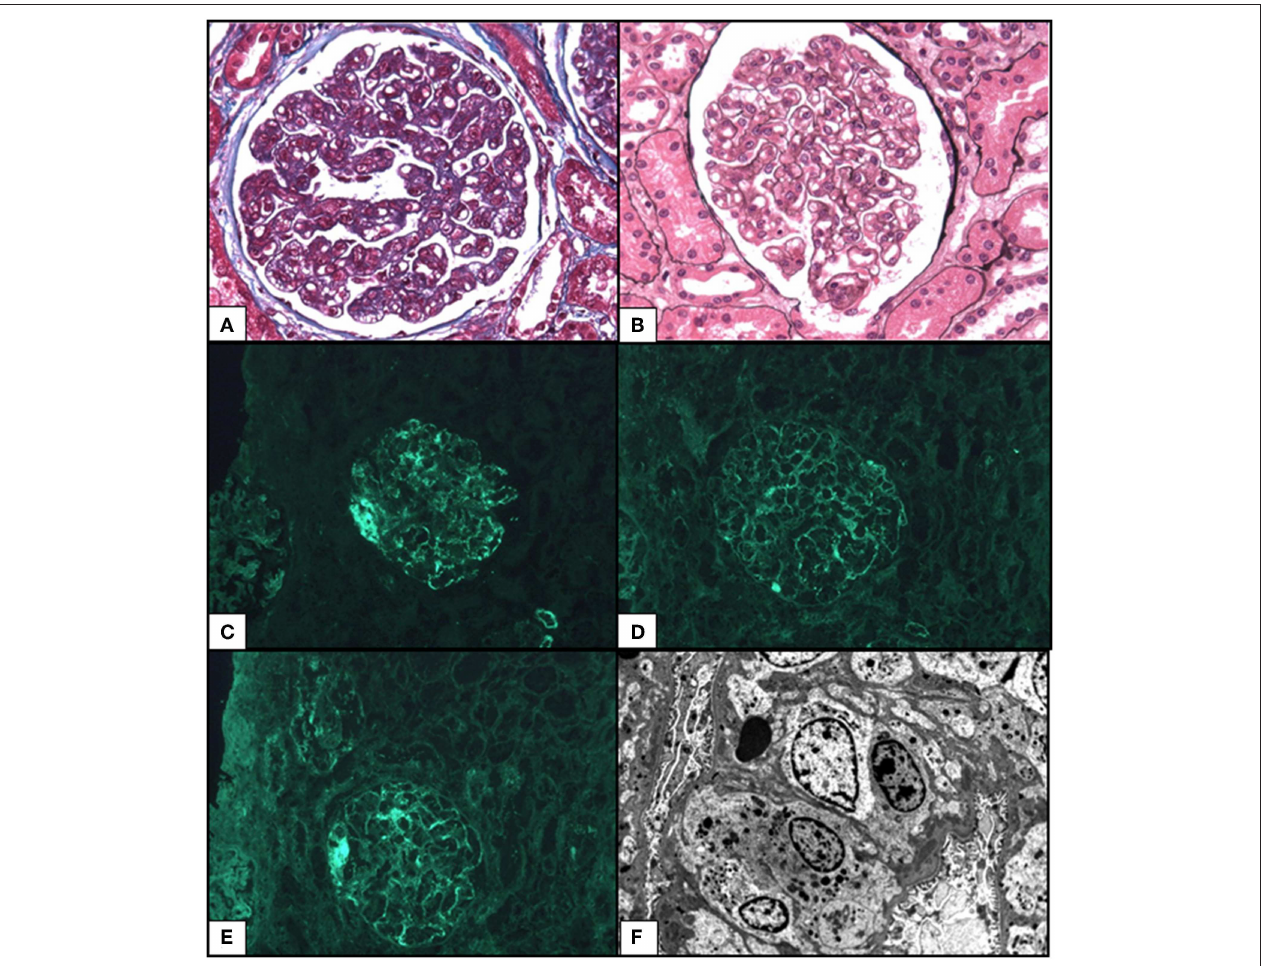
FIGURE 2 | Representative photomicrographs from kidney biopsy of the case: membranoproliferative glomerulonephritis pattern. (A) Increased lobulation with intracapillary hypercellularity by macrophages and neutrophils. Masson’s Trichrome 400x. (B) Thickening of capillary due to multiple double contours. Mild mesangial proliferation. Silver impregnation after Jones 400x. Mild. (C) Segmentary granular capillary walls deposits for IgM. Immunofluorescence (IF) 400x. (D) Mild endomembranous deposits for Lambda light chains. IF 400x. (E) Mild endomembranous deposits for Kappa light chains. IF 400x. (F) Ultrastructural study